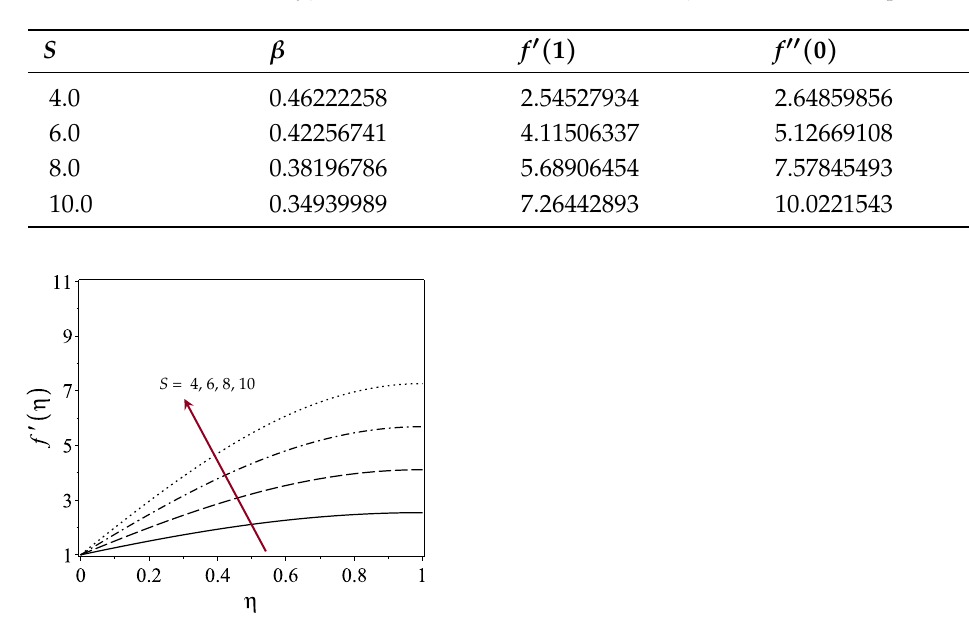
Table 6. Variation of velocity f (cid:48) (1) and dimensionless film thickness β with unsteadiness parameter S .